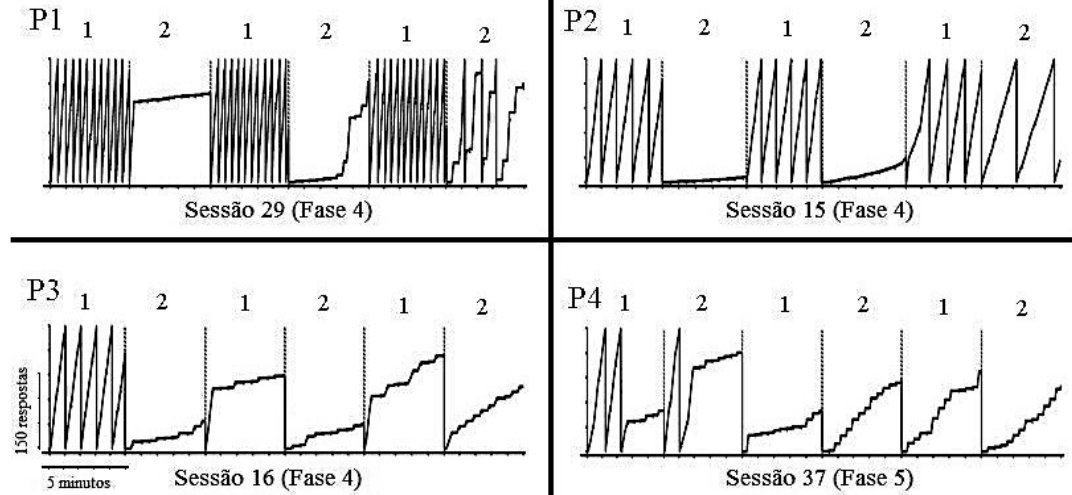
Figura 5. Registros cumulativos das sessões do múltiplo FI-FI nas quais o comportamento dos participantes começou a mudar (sessões da Fase 4 para P1, P2 e P3 e da Fase 5 para P4). Os números nos registros indicam cada componente (1 para FI com botão verde e 2 para FI com botão vermelho). As linhas de resposta voltam a zero após 250 respostas e ao fi nal de cada componente. As linhas pontilhadas indicam o fi nal dos componentes, que tinham duração de cinco minutos. Marcas diagonais na linha de resposta indicam a liberação de